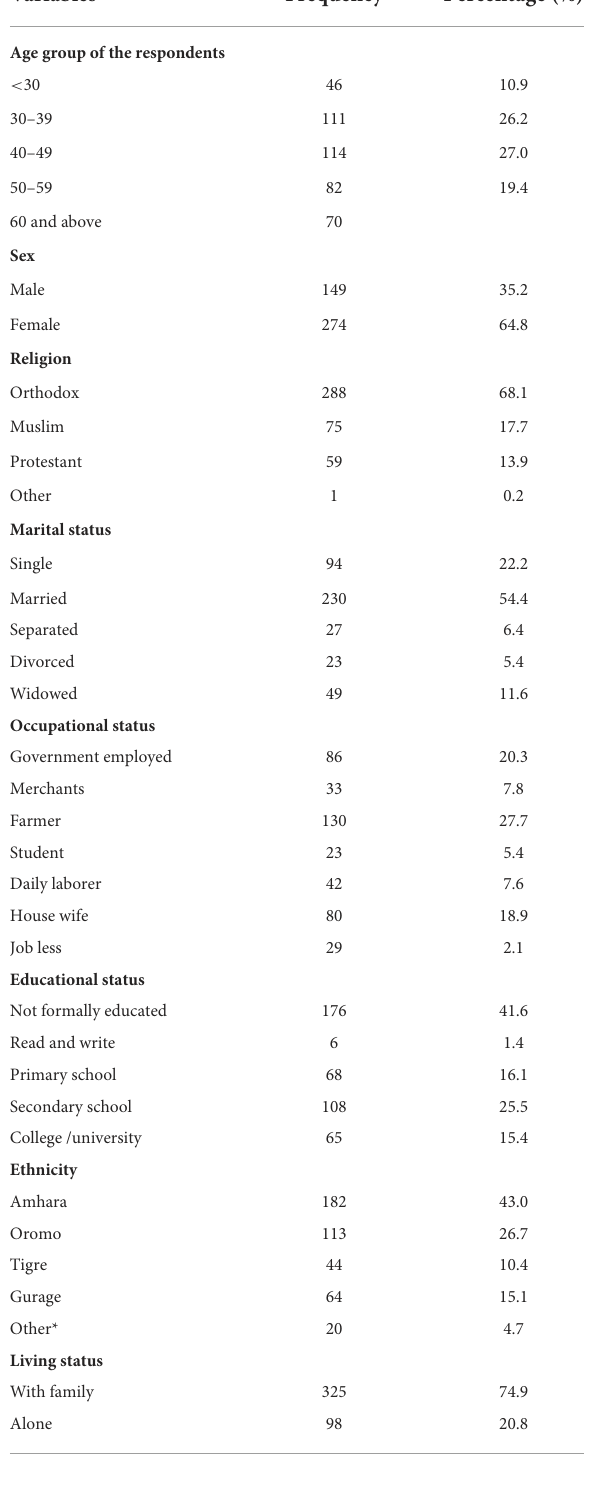
TABLE 1 Frequency distributions of socio-demographic characteristics of the respondents at TASH in Addis Ababa, Ethiopia,